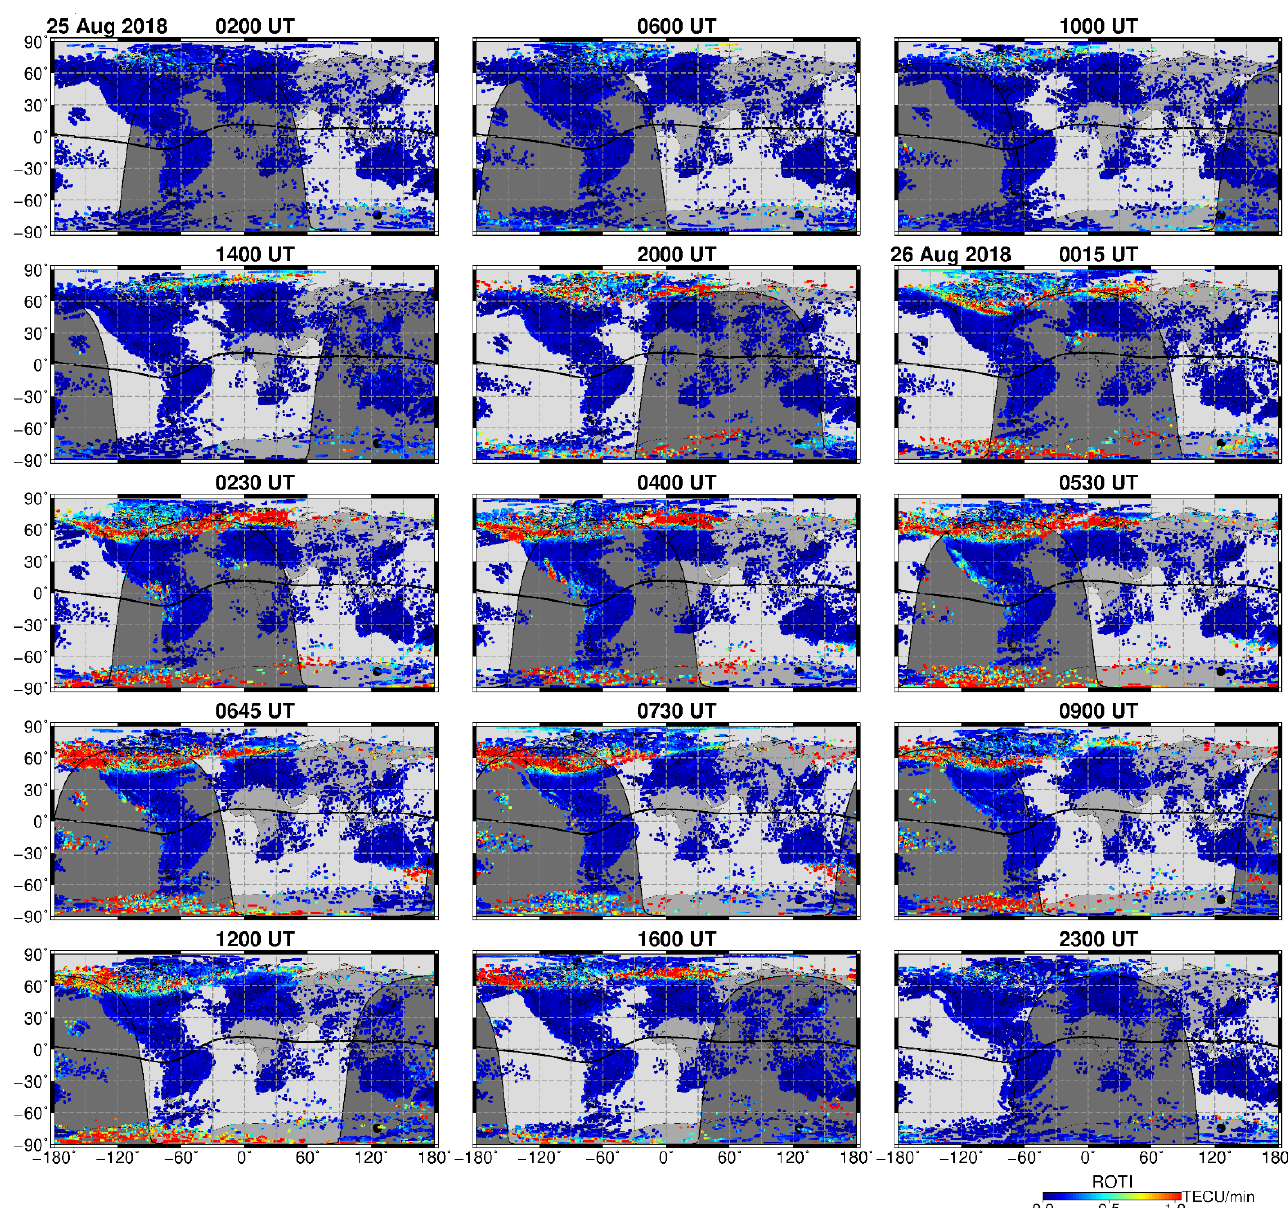
Figure 2. Global GNSS ROTI maps for selected times on 25–26 August 2018. The thick black line marks the magnetic equator, the grey shaded area shows nighttime. High ROTI values (intense red color) depict severe ionospheric irregularities occurrence at equatorial and auroral zones.